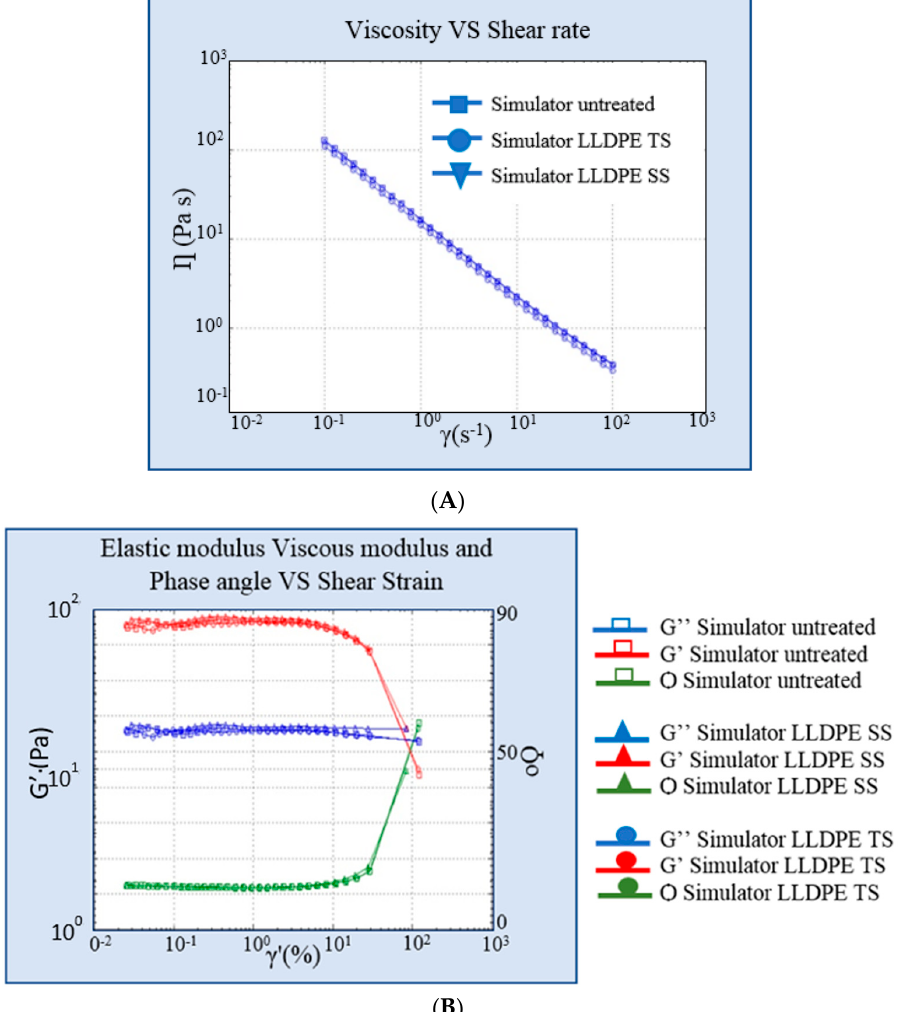
Figure 5. ( A ) Viscosity curve of simulant in linear low-density polyethylene (LLDPE) vs. untreated simulant. ( B ) Elastic and viscous modulus curves of formulation in LLDPE vs. untreated simulant. SS: simulated solar irradiation, TS: thermal shock.